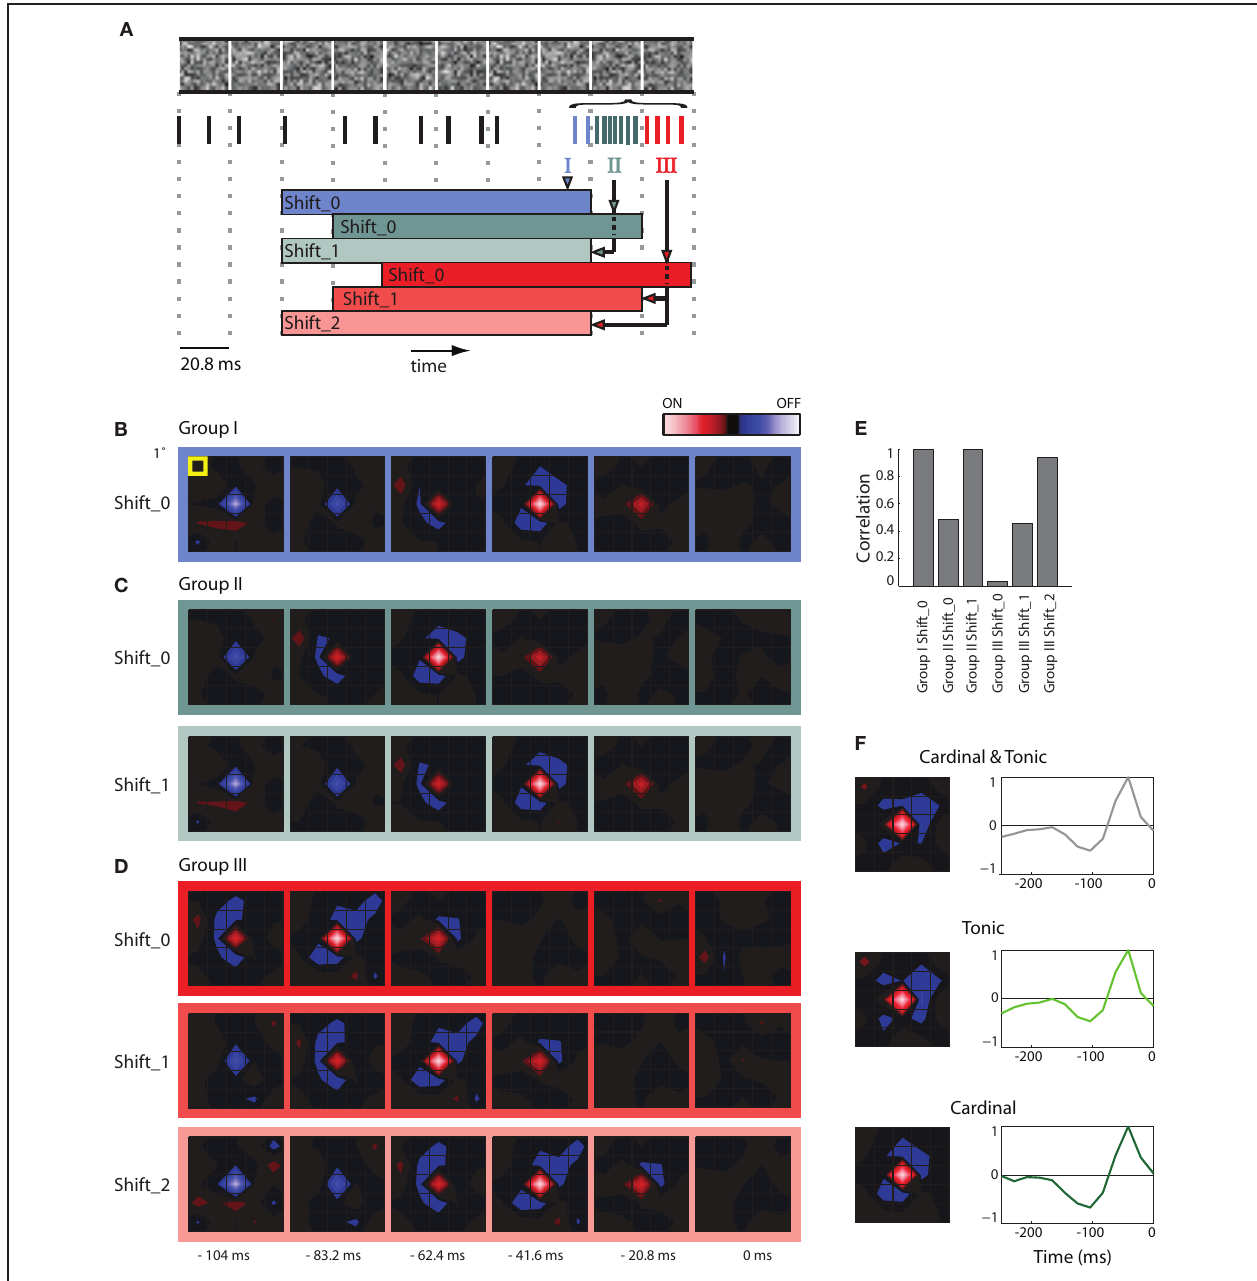
FIGURE 2 | STAs made from burst and tonic spikes. (A) Schematic diagram of a sequence of stimulus frames shown above spikes recorded at the same time; dashed vertical lines help align the different components of the figure with the timing of the stimulus. Some spikes formed a burst; these are color coded according to whether they coincided with the first (Group I, blue), second (Group II, green), and third (Group III, red) frame of the stimulus displayed during the burst. The colored horizontal bars, labeled Shift_0, 1, or 2 beneath the spike train delimit the time window used to compute various STAs made for spikes in Groups, I, II, and III. (B) STA made with Group I spikes for the interval indicated by the blue bar labeled Shift_0, the peak of the STA emerged 41.6ms prior to the neural response. (C) STAs made from Group II spikes for the stimulus frame indicated by the green bars labeled Shift_0 and Shift_1 (the latter was shifted forward in time by 1 frame-length). Note that both STAs are similar to that illustrated for Group 1, Shift _0 (B) ,